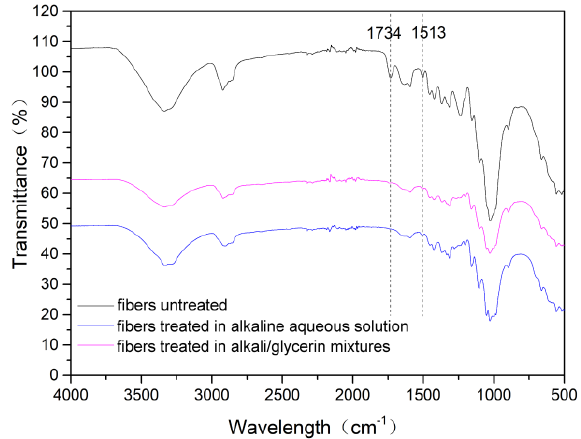
Figure 10. FTIR-ATR spectra of the fibers treated in the alkali/glycerin solution compared with those of the fibers untreated, as well as the fibers treated in the alkaline aqueous